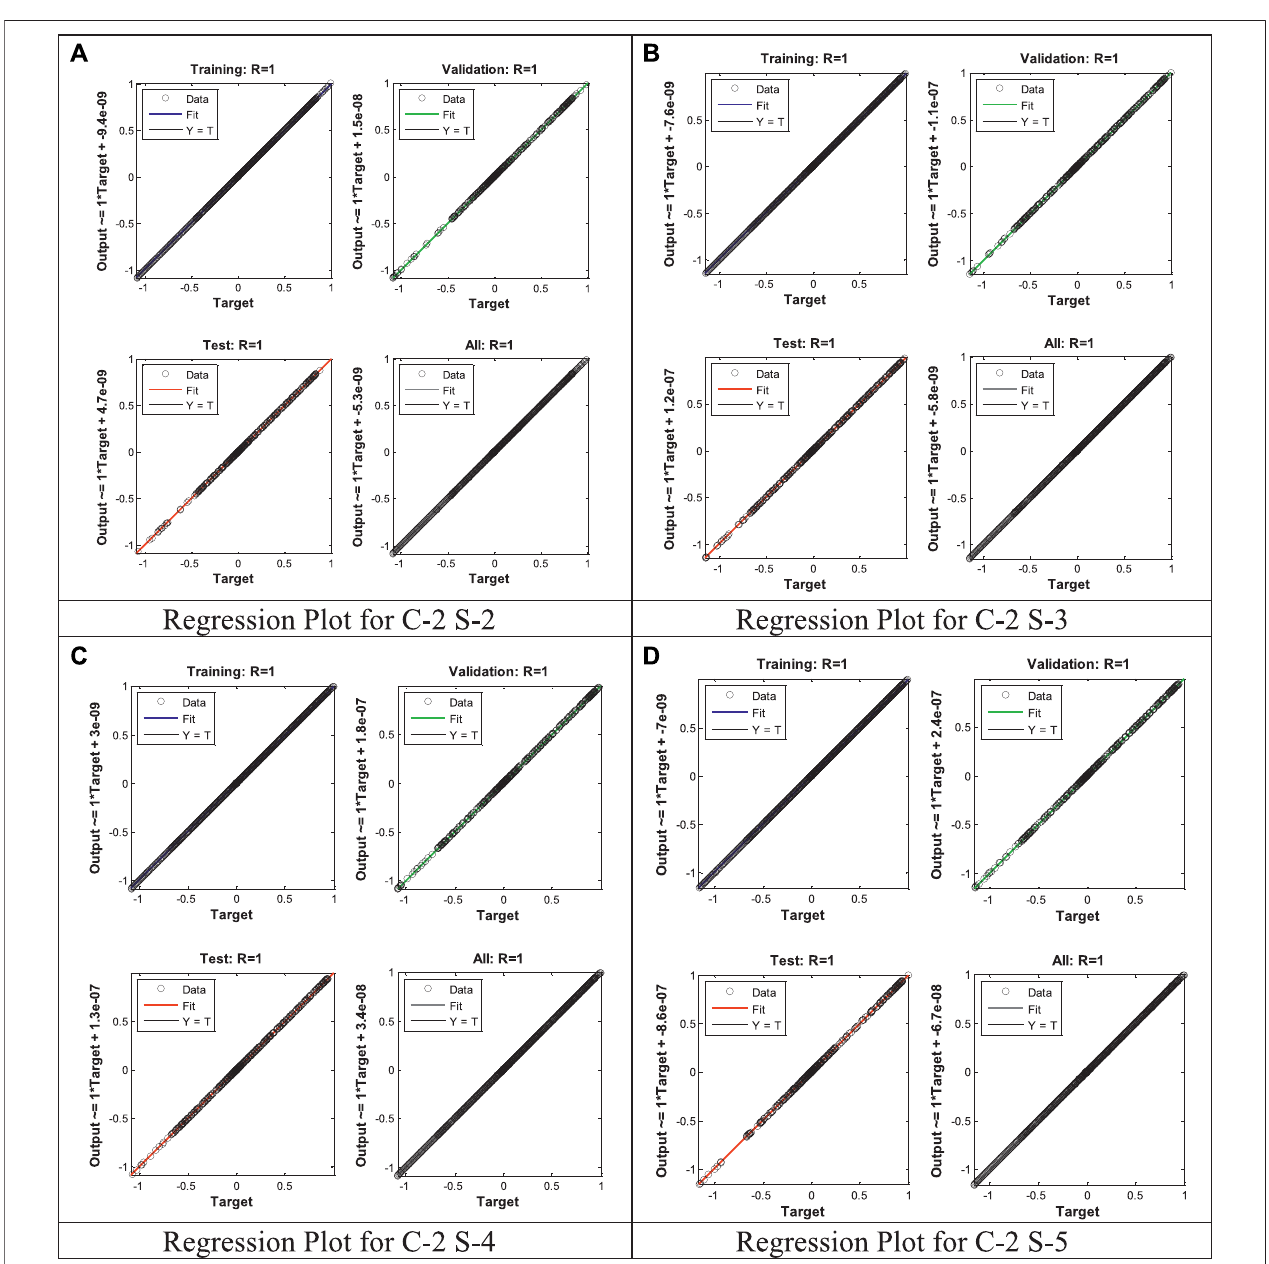
FIGURE 10 | Regression plots of second cases of all